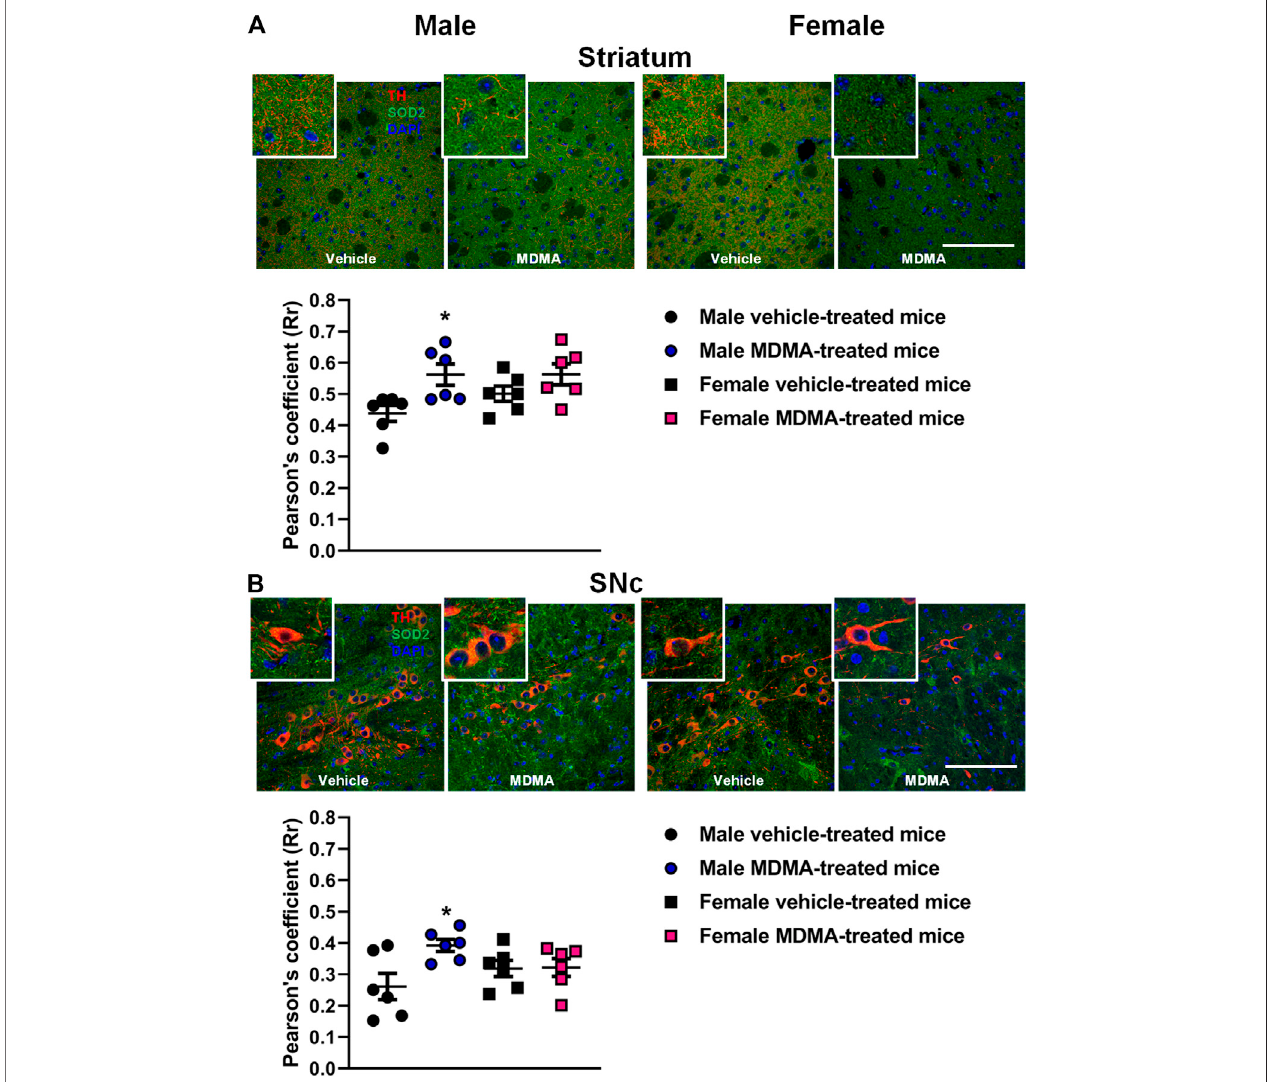
FIGURE 2 | Effectsof treatment with MDMA on the co-localization ofsuperoxide dismutase 2(SOD2) with fi bers and neurons positive to tyrosine hydroxylase (TH) in the striatum (A) and substantia nigra pars compacta (SNc) (B) . Adult male and female mice were treated with either MDMA (4 × 20 mg/kg, i. p. 2 h apart) or vehicle (saline solution, i. p.). N (cid:2) 6 mice per group. Values are reported as mean ± S.E.M. * p < 0.05 compared with the respective group of vehicle-treated mice by Newman- Keuls post-hoc test. Scale bar: 50 µm.